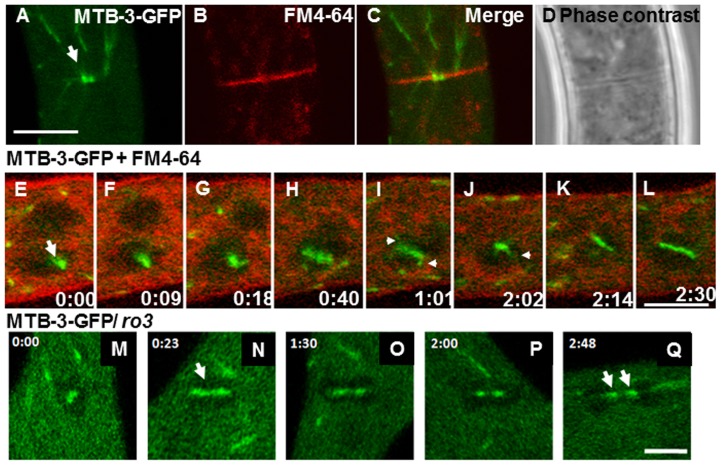
Localization of MTB-3-GFP in different hyphal regions of N. crassa.(A–D) MTB-3-GFP remains close to the septal pore. (A). Septum of a mature hypha expressing MTB-3-GFP. (B) Membranes stained FM4-64 (C) Merged image of (A), (B) and (D) Phase contrast image. Arrow points to MTB-3-GFP accumulation in the completely formed septal pore when it is already formed. Scale bar = 10 µm. (E–L) Confocal time lapse images of a nucleus during mitosis in mature hypha of a strain expressing MTB-3-GFP, merged with images of membranes stained with FM4-64. The arrow points to accumulation of MTB-3-GFP on the spindle of a nucleus in mitosis. Arrowheads indicate the presence of MTB-3-GFP in what seem to be astral MTs. Time scale is in min∶sec. Scale bar = 5 µm. (M–Q) Confocal time lapse images of a nucleus during mitosis in a strain expressing MTB-3-GFP in the ro-3 mutant. Arrows show MTB-3-GFP in the spindle, even when karyokinesis has been completed. Time scale is in min∶sec. Scale bar = 5 µm.